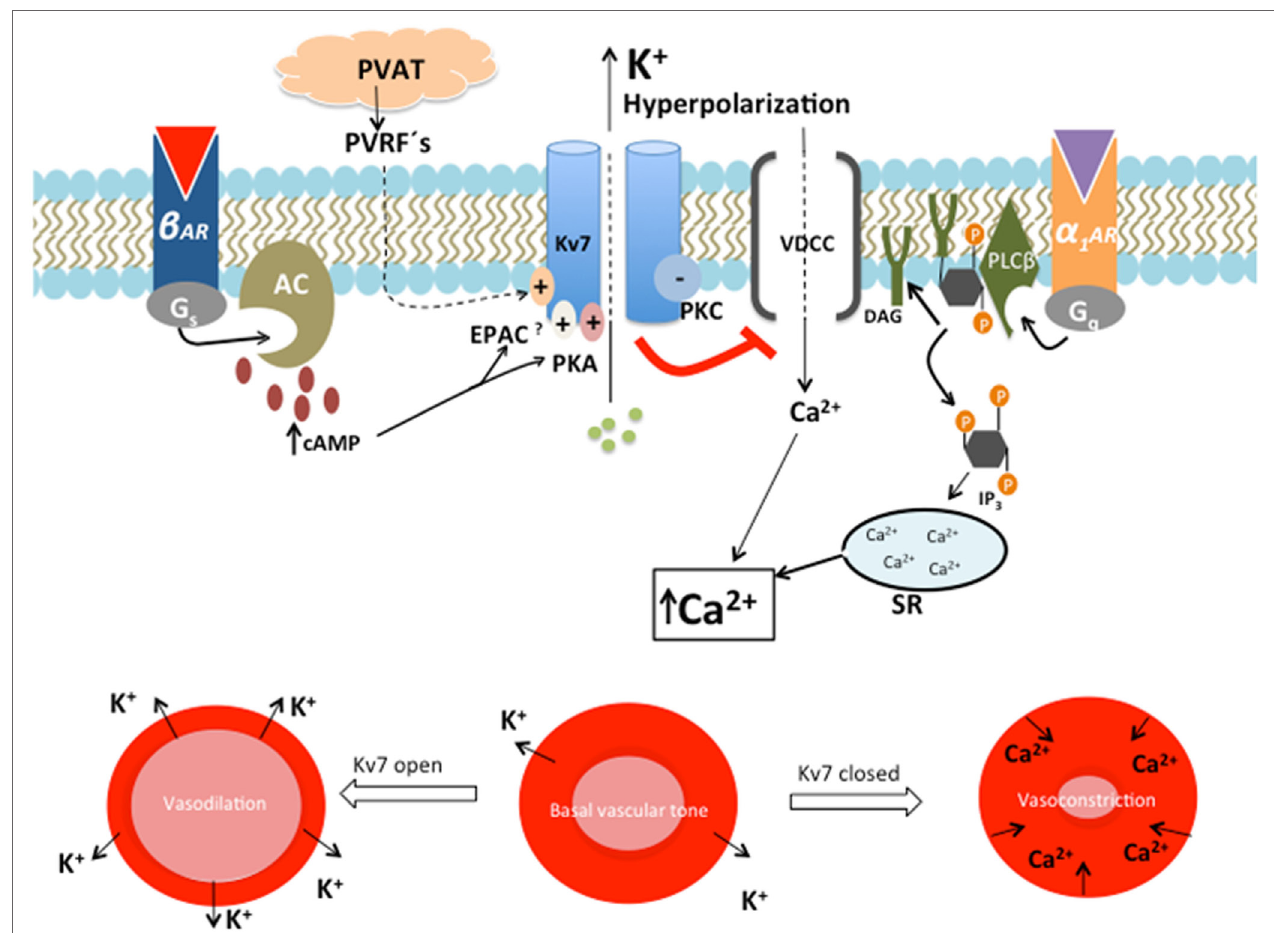
FiGURe 2 | The role of Kv7 in regulating the contractile state of smooth muscle. β -Adrenergic, cyclic AMP (cAMP)-mediated activation of Kv7 leads to outward directed K + current, with subsequent hyperpolarization, reduced opening of voltage-dependent Ca 2 + channels (VDCC) and vasodilation of the vascular smooth muscle cell. This action opposes the activation of G q -linked receptors, α 1 -adrenergic receptor ( α 1 AR ), which negatively regulates Kv7 activity by the actions of the protein kinase C (PKC)-mediated pathway. This decreased Kv7 activity leads to depolarization, which opens VDCC. Ca 2 + is simultaneously released from sarcoplasmic reticulum (SR) as a response to inositol triphosphate (IP 3 ). This rise in intracellular Ca 2 + leads to vasoconstriction (47). The expression and function of Kv7.4 are impaired in SHR. This results in decreased β -adrenergic, cAMP-mediated Kv7.4 activation, with a shift toward α 1 AR activity. Reduced Kv7.4 activity and α 1 -adrenoceptor hyperactivity lead to a rise in intracellular Ca 2 + concentration and subsequent vasospasm (21). The vasodilatory effect of perivascular relaxing factors (PVRFs) released by perivascular adipose tissue (PVAT) may be mediated through opening of